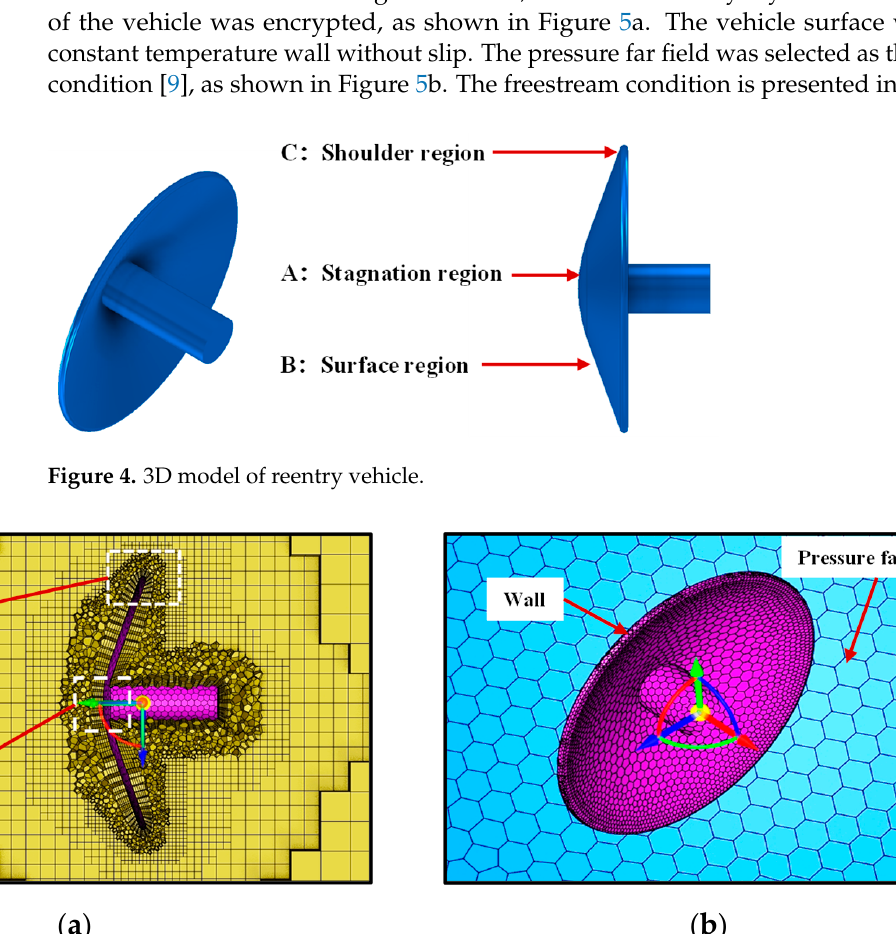
Figure 5. Mesh division of reentry vehicle: ( a ) mesh detail; ( b ) boundary condition scheme. Table 2. Initial freestream conditions.